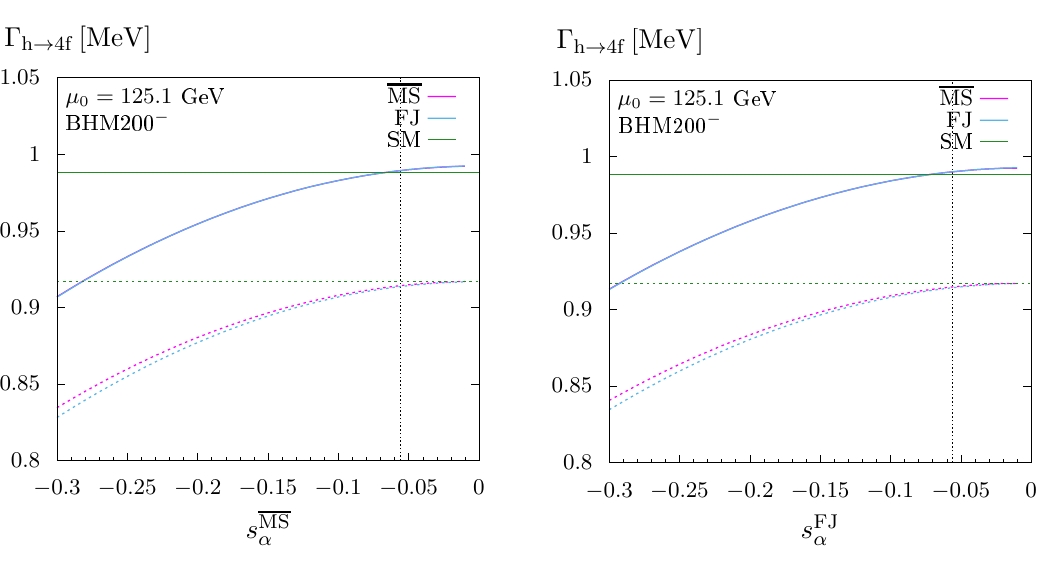
Figure 27 . As in (cid:12)gure 12, but for benchmark scenario BHM200 (cid:0) .